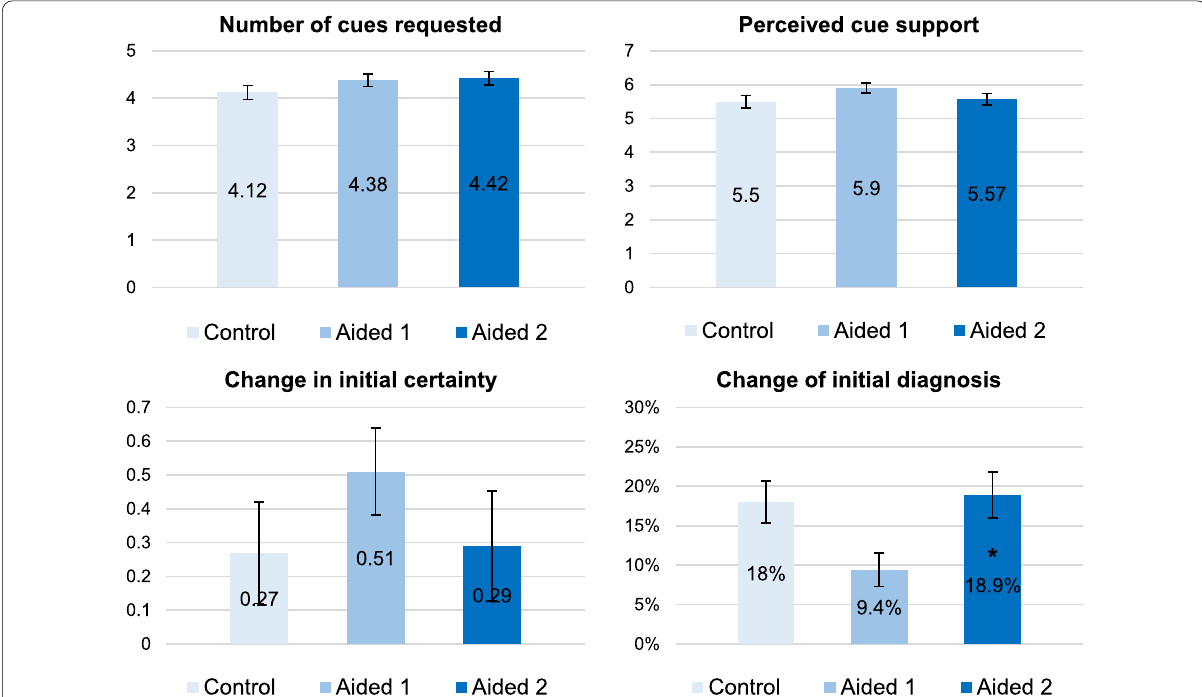
Fig. 4 Results of the variables of interest by condition. Top left panel: mean number of cue requests; Top right panel: mean perceived cue support (scale); Bottom left panel: mean change in initial certainty (scale); bottom right panel: percentage change of initial diagnosis following cue requests. * denotes significance at the level of 0.05 between Aided 1 and Aided